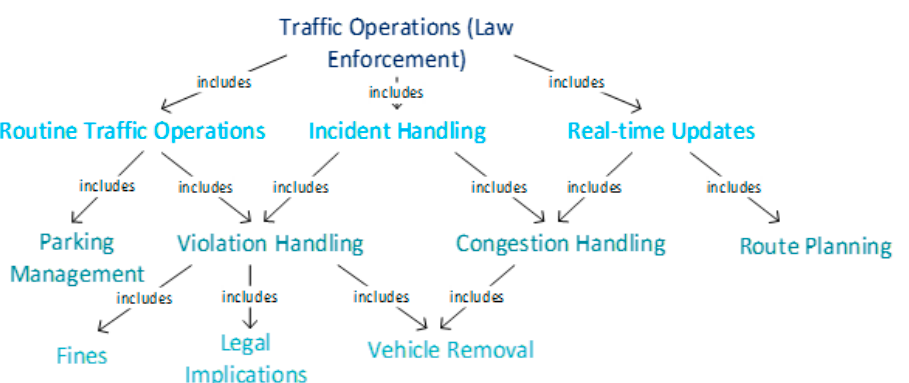
Figure 6. Implicit collection purpose hierarchy for an SC-TMS.